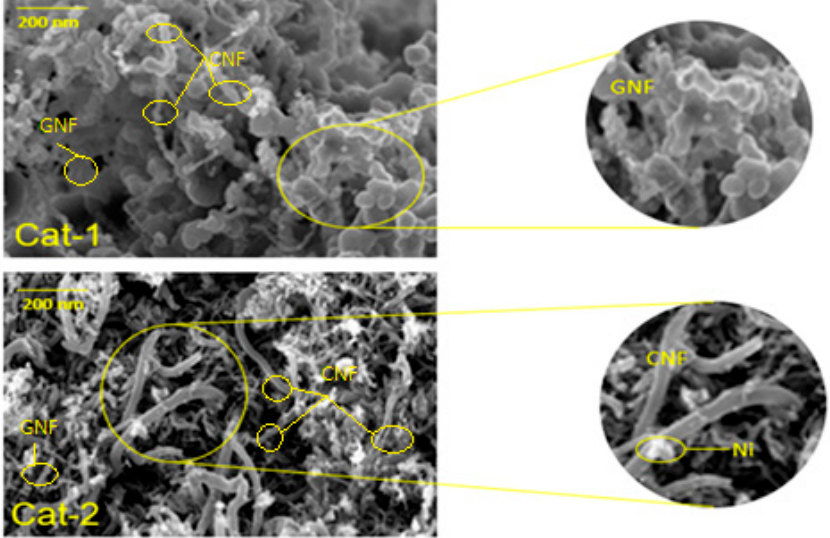
Figure 6. FESEM images of carbon deposited on the